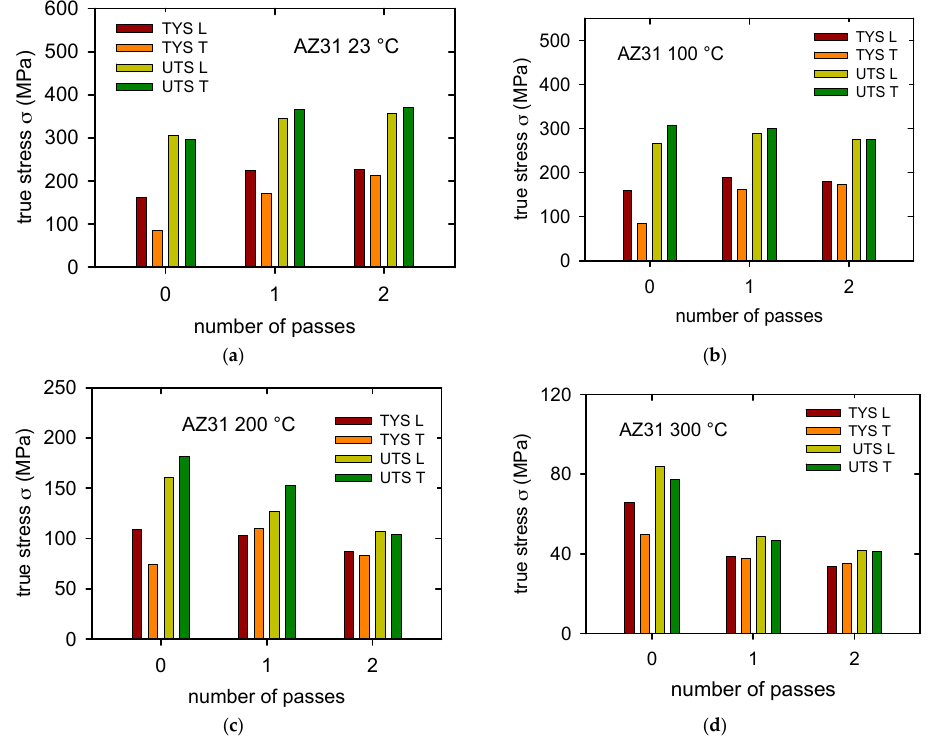
Figure 11. Characteristic stresses obtained for samples in L- and T-orientation after 0, 1 and 2 rolling passes at ( a ) room temperature; ( b ) 100 °C; ( c ) 200 °C and ( d ) 300 °C.